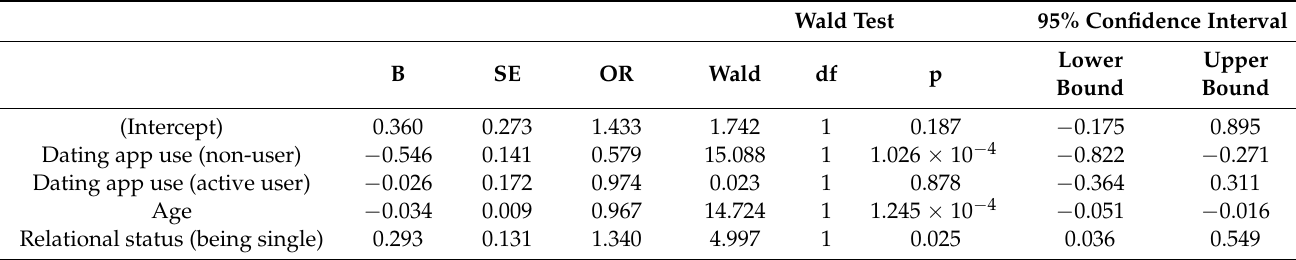
Table 3. Output of logistic regression model featuring age, relational status, and dating app use (non-user vs. former user vs. active user) as predictors for cannabis